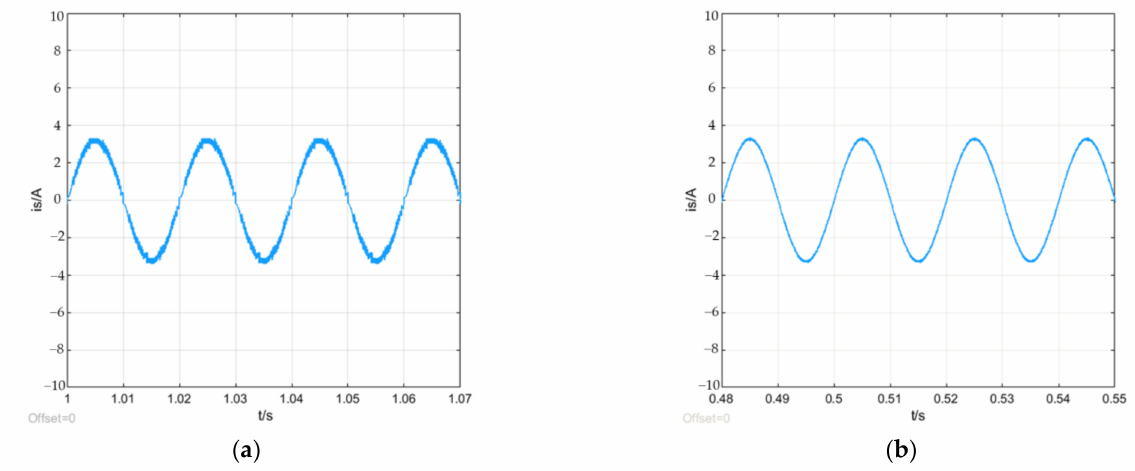
Figure 10. Simulated current waveforms. ( a ) FCS-MPC; ( b ) the proposed MPCC.